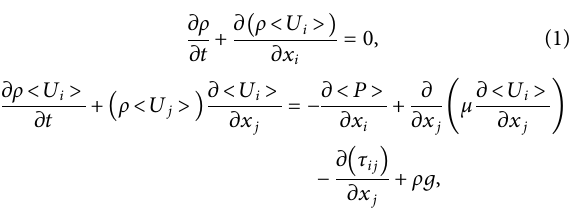
FIGURE 2 Mesh for the T-junction (full inlets and outlets have been cropped).